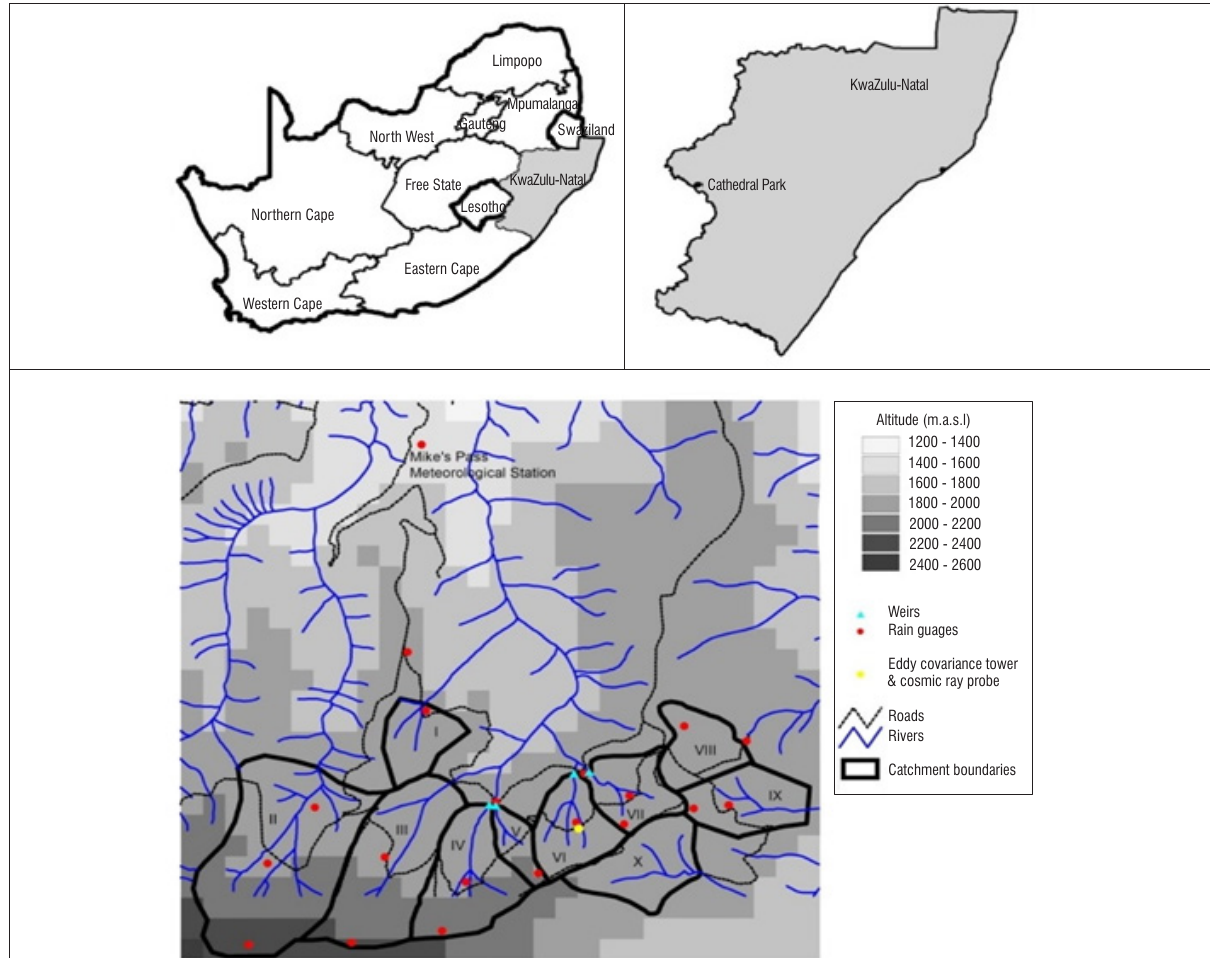
Figure 1: Location of Cathedral Peak Catchment VI, within the Tugela Catchment, in the KwaZulu-Natal Province, South